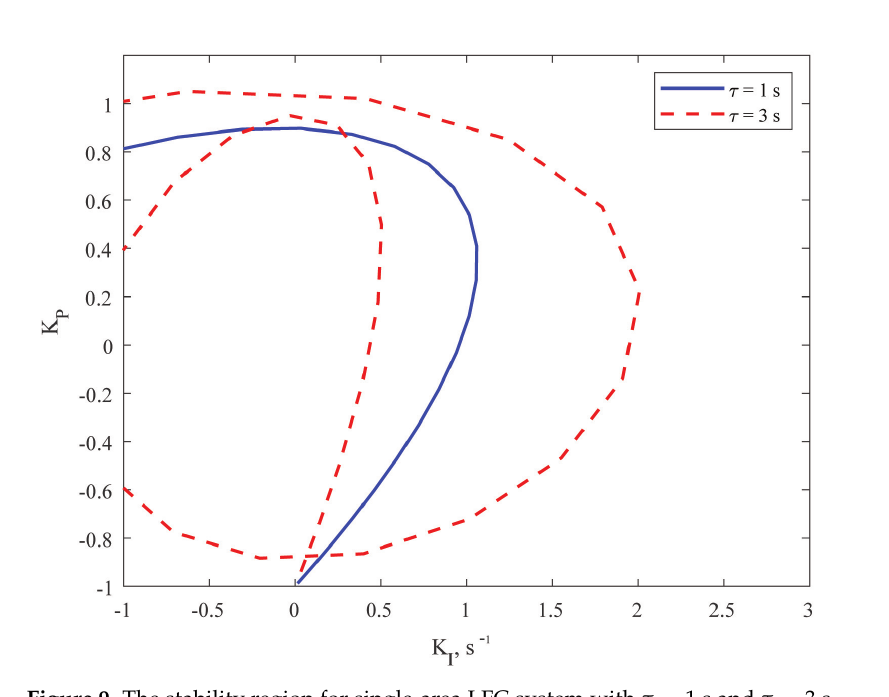
Figure 9. The stability region for single-area LFC system with τ = 1 s and τ = 3 s.